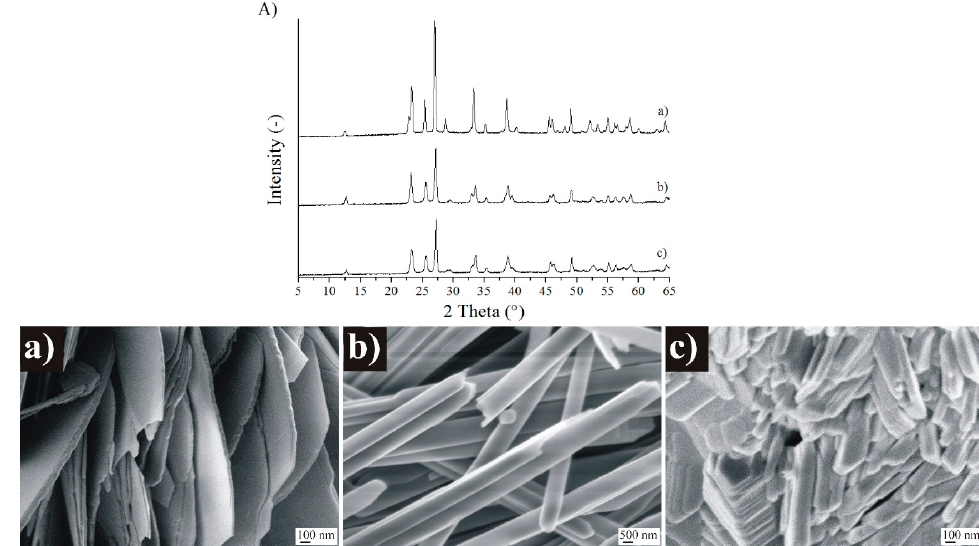
Figure 6. XRD patterns ( A ) and SEM images of different MoO 3 phases after the 500 °C heat treatment., (a) MoO 3 -10, monoclinic phase (CrCl 3 , 240 °C, 6 h), (b) MoO 3 -8, orthorhombic phase (CTAB, 240 °C, 6 h), (c) MoO 3 -1, hexagonal phase (90 °C, 3 h).